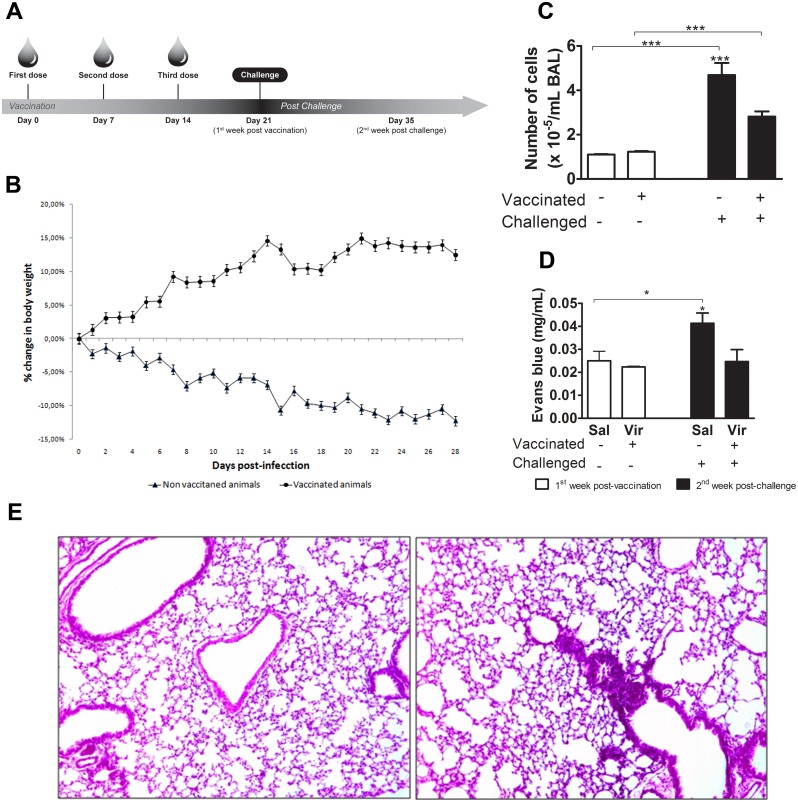
Vaccinated mice are protected against challenge.(A) Study design: BALB/c mice were vaccinated intranasally with the pressurized H3N8 at the indicated time points, followed by an intranasal challenge with the native virus. (B) The vaccinated and further challenged animals were monitored daily for body weight changes. The results are expressed as the mean of 10 animals. The mice were monitored for 28 days. (C) Total cell counts in the bronchoalveolar lavage (BAL) fluid are shown. At days 21 and 35 of the study, BAL was performed on the animals (n = 6) to analyze cellularity. The bars represent the averages and respective standard deviations of the individual results. (D) The measurement of Evans Blue dye in the lungs is shown. The animals (n = 9) were anesthetized and injected with an endovenous solution and 2% Evans Blue. After 1 hour, the animals were euthanized and perfused through the right atrium with physiological saline. Next, the lung was removed and placed in 5 mL of formamide for 18 h at 37°C. The supernatant was then collected and the absorbance of the Evans Blue dye was measured. The result was evaluated in mg/mL Evans Blue by making a standard curve. The bars represent the means and respective standard deviations of the individual results. (E) Histological sections of the lung parenchyma of the mice vaccinated and further challenged are shown. I: vaccinated challenged BALB/c, II: non-vaccinated challenged mice. The lungs were collected 7 days after challenge. The blocks were cut on a microtome to a thickness of 5 μm, and the slides were stained with hematoxylin and eosin for the morphological analysis. The slides were photographed using an Olympus BX41 microscope coupled to a photographic system at 100X magnification. Sal = Saline, Vir = Pressure-inactivated virus, PV = Post vaccination. P.I. = Post-infection with native virus. The asterisk (*) marks a significant difference (* p <0.05, ** p <0.01, *** p <0.0001 and a Student-Newman-Keuls post-test).